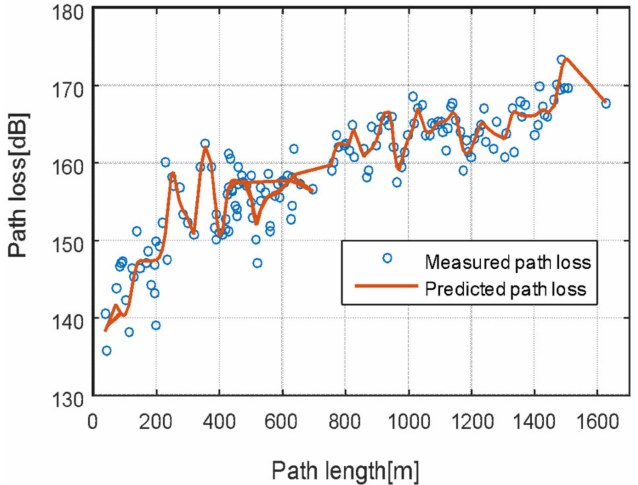
Figure 9. Comparison between measured loss and the prediction ANN model in site